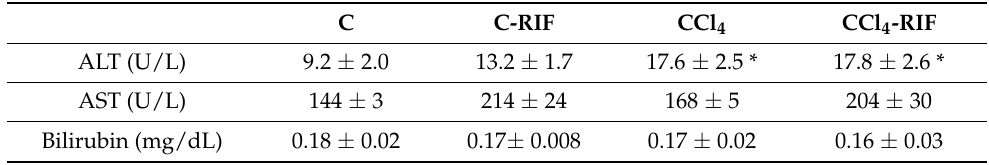
Table 1. Liver inflammation: content of cytokines. Changes in liver cytokines at 4 weeks of treatment with CCl 4. The levels of all cytokines was analyzed by western blot. Data are the mean ± SEM of the indicated number of rats and are given as percentage of control rats. Six rats per group were used for this analysis. One-way ANOVA and Bonferroni’s or Dunnett’s tests for multiple comparisons were performed. Values significantly different from control rats are indicated by asterisks, * p < 0.05; statistical differences between CCl 4 and CCl 4 -RIF are indicated by “a”, p < 0.05. Representative bands of liver cytokines western blots are shown in Figure 3. Table 2. Hepatic enzyme activities in serum. Transaminase activity and bilirubin levels were assessed as indicators of liver injury. Six rats per group were used for this analysis. One-way ANOVA and Bonferroni’s or Dunn’s tests for multiple comparisons were performed. Values significantly different from control rats are indicated by asterisks, * p < 0.05.